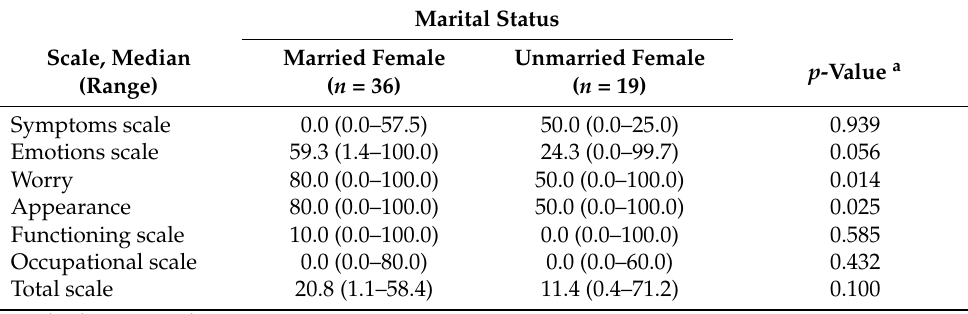
Table 3. Correlation of marital status with QoL of female vitiligo